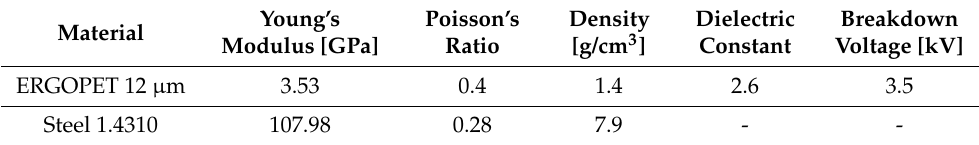
Table 1. Selected properties of actuator constituent materials.